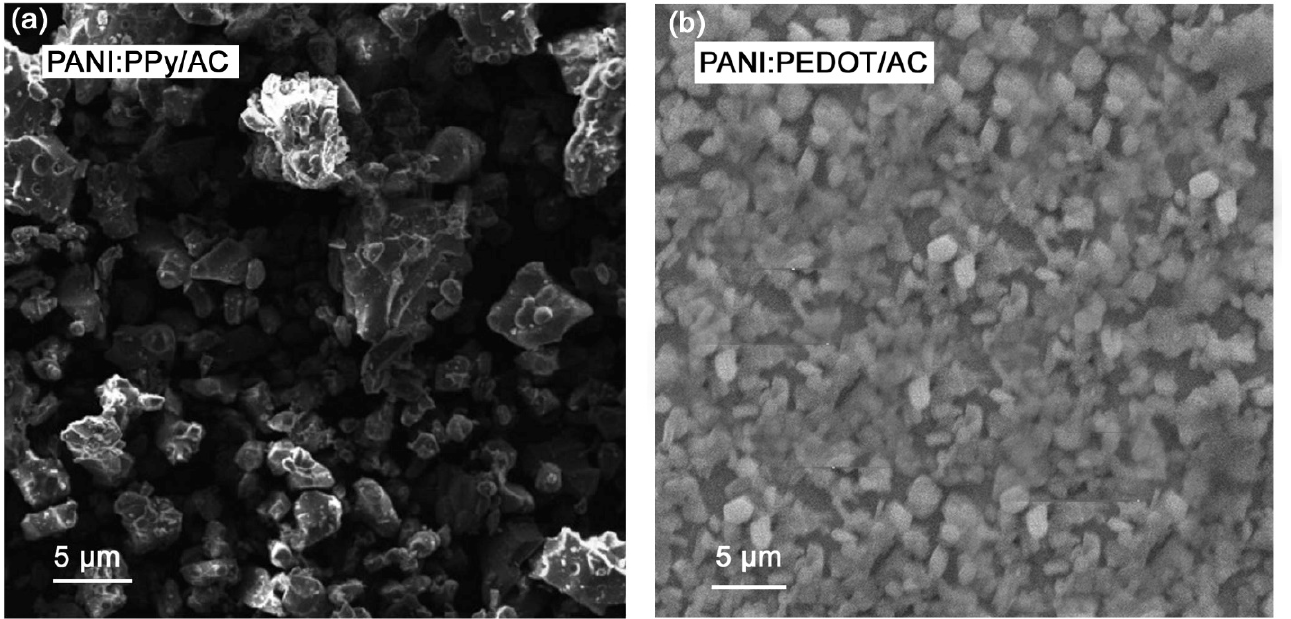
Figure 3. SEM images obtained for ( a ) PANI:PPy/AC and ( b ) PANI:PEDOT/AC